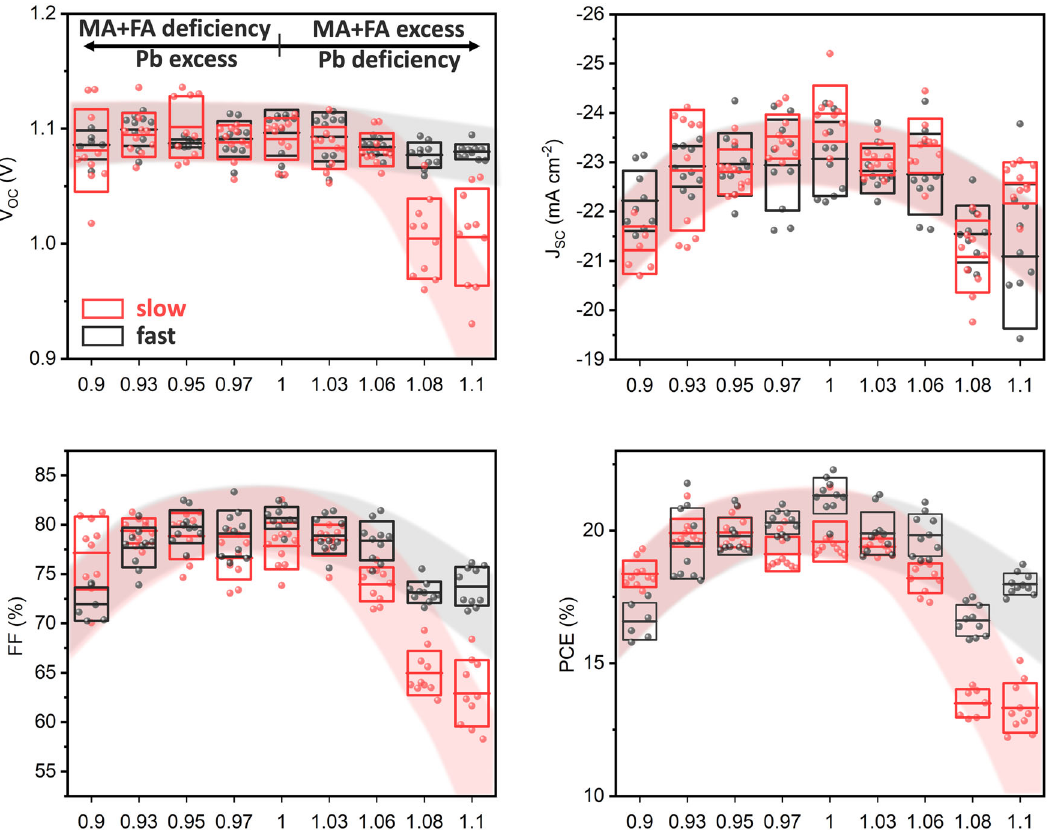
Fig. 7 PV performance of triple-cation perovskite solar cells with varying stoichiometric ratios, for fast and slow antisolvent application rates. [MA + FA] 1 is the amount of organics in an exactly stoichiometric precursor solution. For clarity, only the top ten devices for each category are shown. The center line denotes mean value, box limits are upper and lower quartiles. The red and black shaded regions are shown as a guide for the